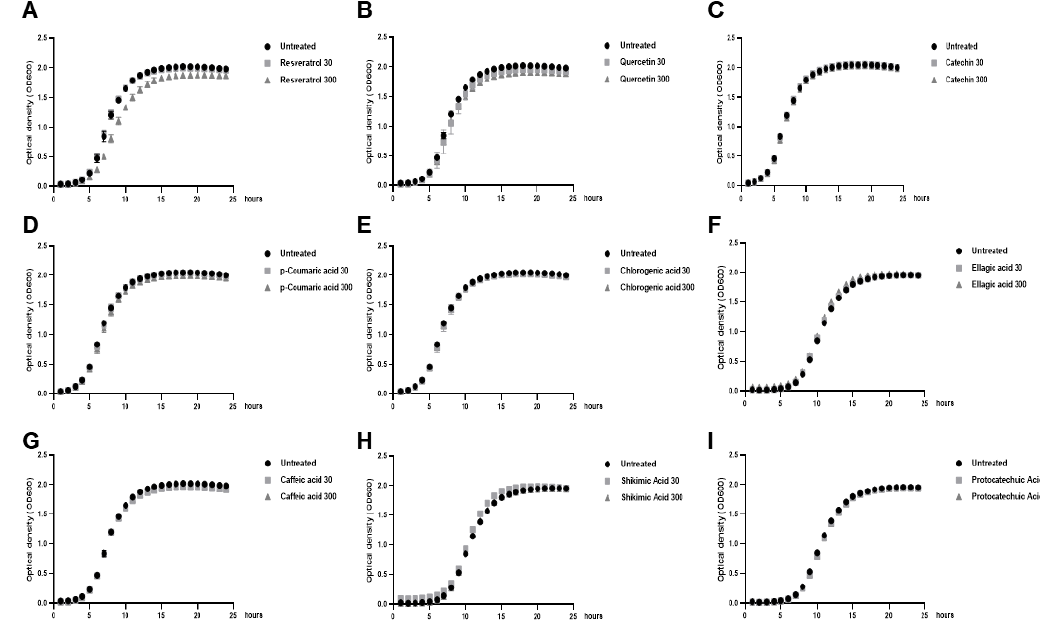
Figure A1. Growth curves of L. paracasei ATCC334 treated with various polyphenols. ( A – I ). Growth curves of L. paracasei ATCC334 untreated (black filled circle) or incubated with 30 µ M (gray-filled square) or 300 µ M (gray-filled triangle) of the indicated polyphenols in MRS medium at 37 ◦ C. The OD 600 was monitored at 1 h intervals for 24 h. Values represent mean ± SEM of three independent experiments.